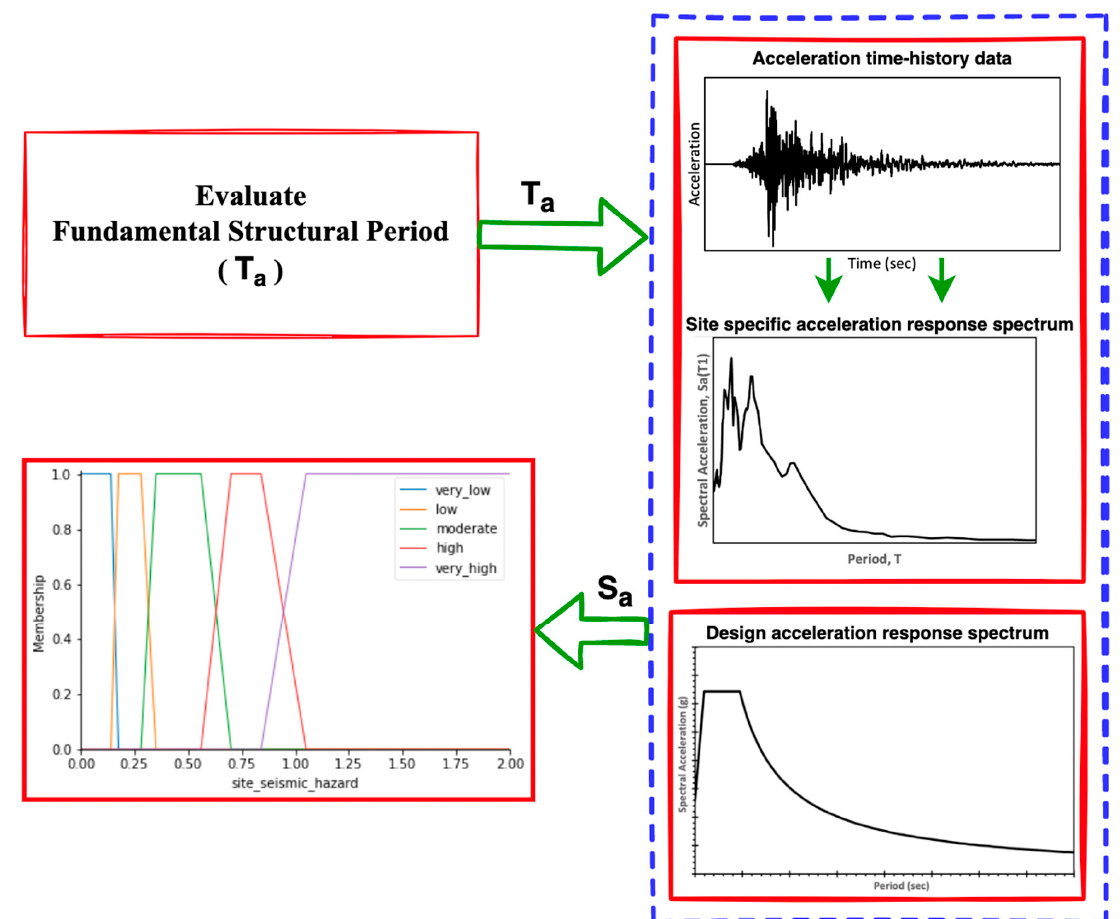
Figure 3. Evaluation of site seismic hazard module (compiled by authors based on Tesfamariam & Saatcioglu [40]).